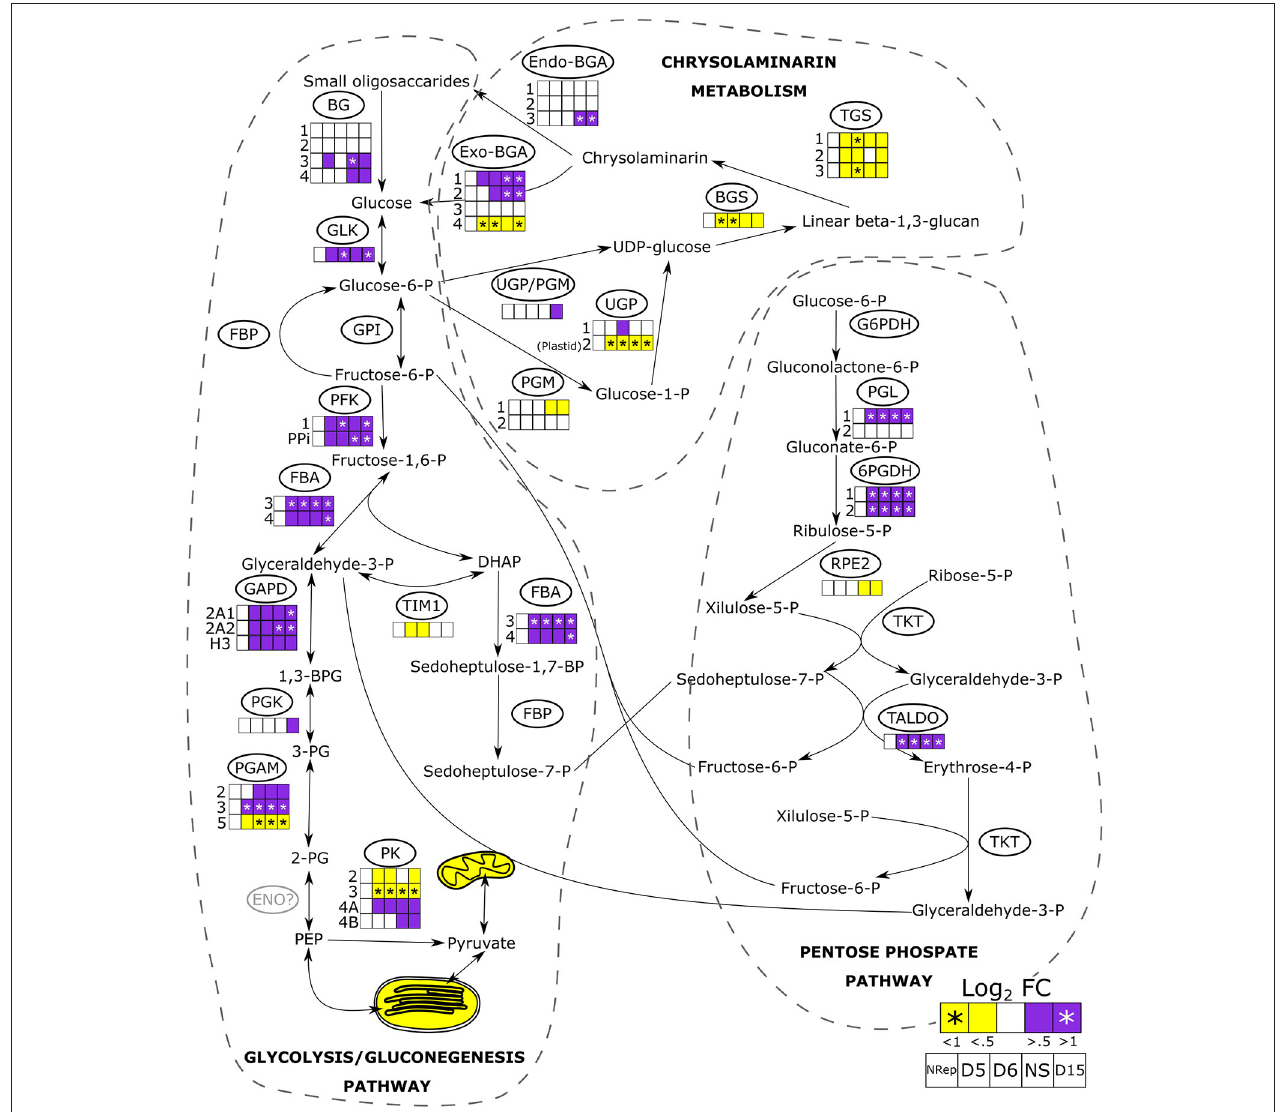
FIGURE 6 | Transcriptional changes of the genes involved in glycolysis/gluconeogenesis, pentose phosphate pathways, the synthesis and degradation of chrysolaminarin. Heatmaps are reported when changes in gene expression were observed in at least one of the isoforms. Mitochondrial and plastidial transcriptional changes are reported as overall change, the detailed pathway and transcript abundance change are reported in Supplementary Figure 12 . Full information on the gene expression change during the time-course of the experiment is reported in Supplementary Figure 13 . BG, β -glucosidase, GLK, glucokinase; GPI, glucose-6-phosphate isomerase; FBP, fructose-1,6-bisphosphatase; PFK, phosphofructokinase; FBA, fructose bisphosphate aldolase; GAPD, glyceraldehyde-3-phosphate dehydrogenase; PGK, phosphoglycerate kinase; PGAM, phosphoglycerate mutase; ENO, enolase; PK, pyruvate kinase; TIM, triosephosphate isomerase; G6PDH, glucose 6-phosphate dehydrogenase; PGL, 6-phosphogluconolactonase, 6PGDH, phosphogluconate dehydrogenase; RPE2, ribulose-phosphate 3-epimerase; TKT, transketolase; TALDO, transaldolase; UPG/PGM, UDP-glucose-pyrophosphorylase/phosphoglucomutase; PGM, phosphoglucomutase; UGP, UTP–glucose-1-phosphate uridylyltransferase; BGS, 1,3-beta-glucan synthase; TGS, 1,6- β -transglycosylases; Exo-BGA, exo- β -glucanase; Endo-BGA, endo- β